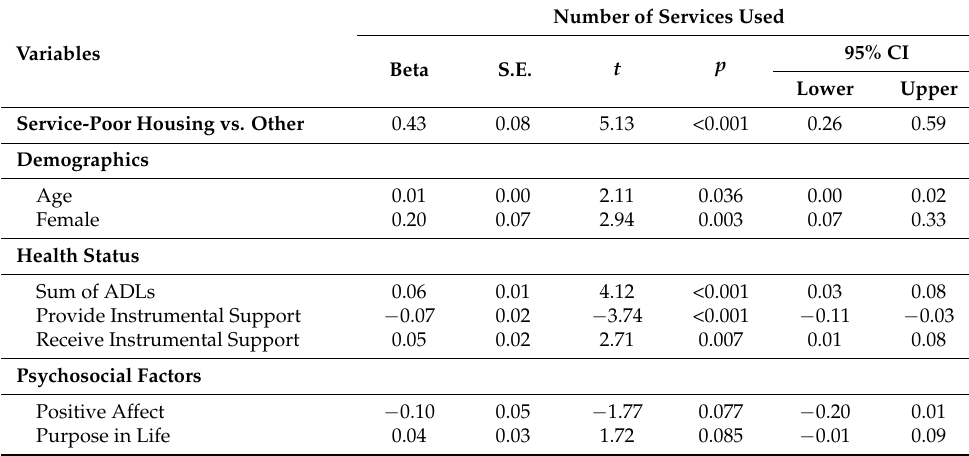
Table 3. Linear regression examining factors associated with service